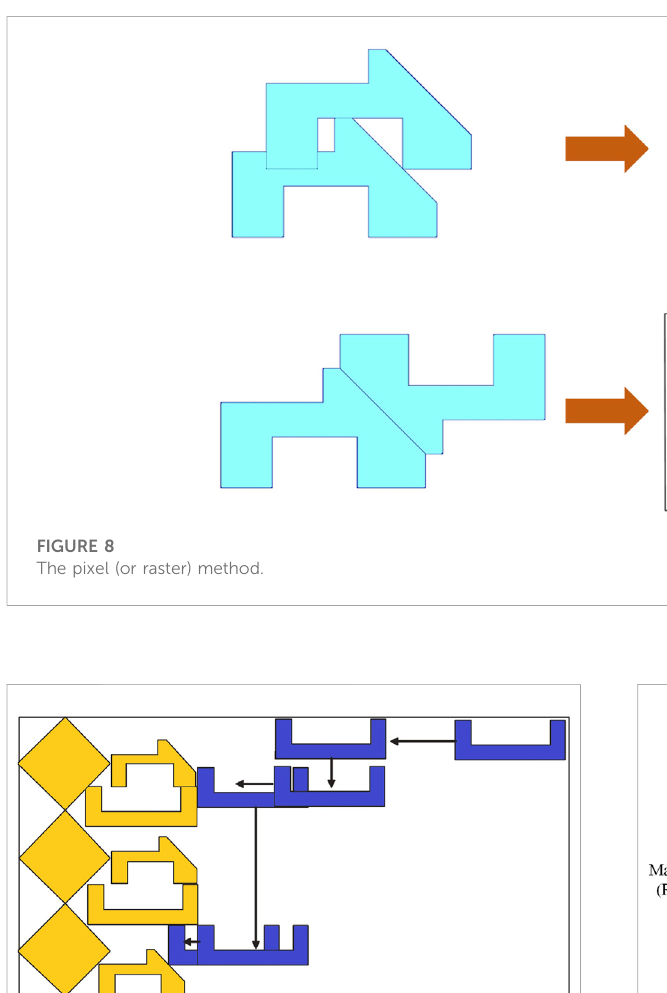
FIGURE 9 BL placement rules.